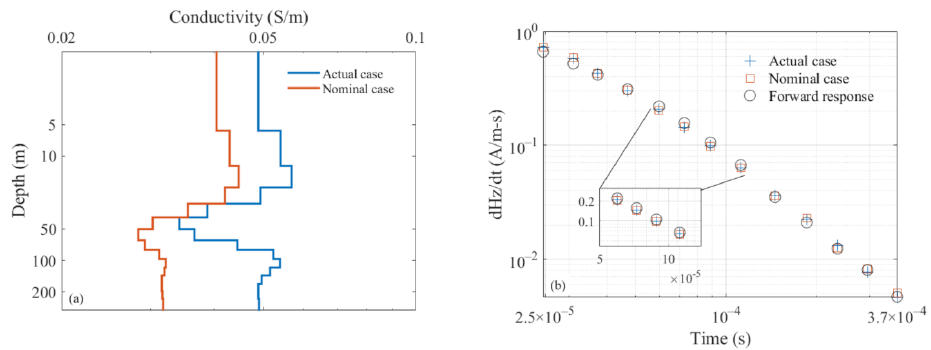
Figure 7. ATEM field data inversions. ( a ) model recovered with and without actual survey geometry considered. ( b ) observed and predicted data